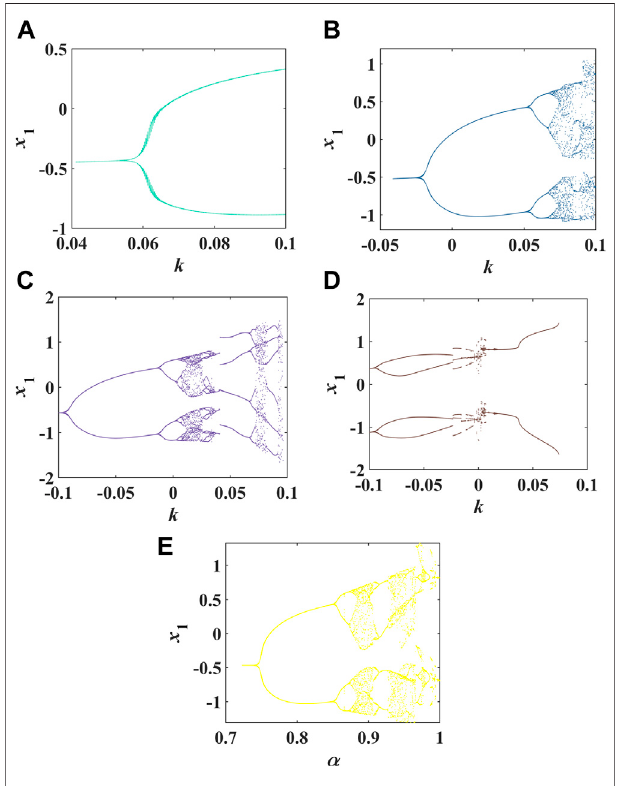
FIGURE 4 | The bifurcation diagram of 6D-FMHNN with respect to parameter k (A) when the differential order is 0.7; (B) when the differential order is 0.8; (C) when the differential order is 0.9; (D) when the differential order is 1 and the bifurcation diagram of 6D-FMHNN with respect to order when the memristor coupling strength k is 0.02 (E) .